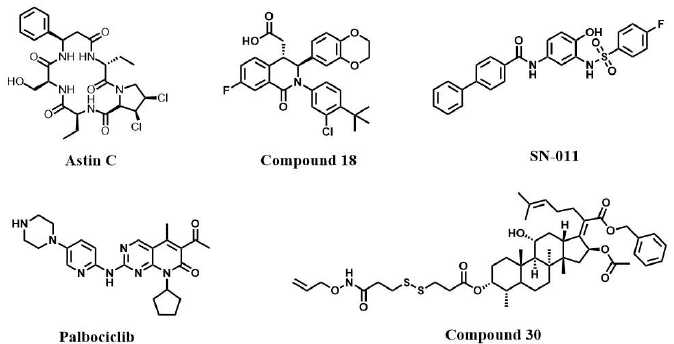
Figure 5. STING inhibitors targeting CDN binding sites.